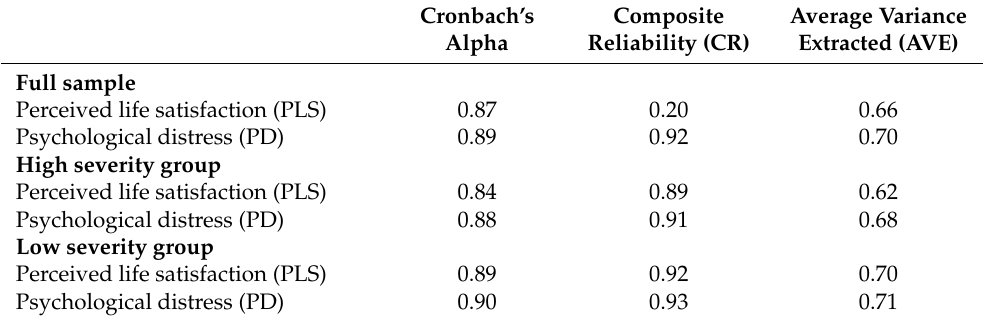
Table 1. Measurement reliability